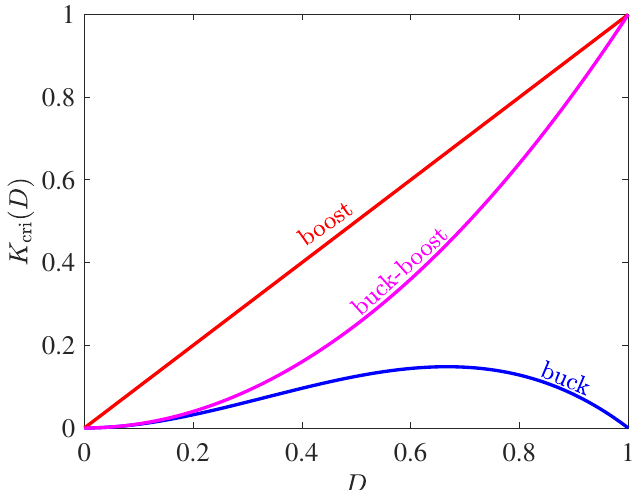
Figure 7. The critical value K cri of K at the boundary CCM–DCM for elementary switching converters loaded by a CPL. For a specific value of D , if K > K cri ( D ) , CCM takes place, and if K < K cri ( D ) , DCM occurs.